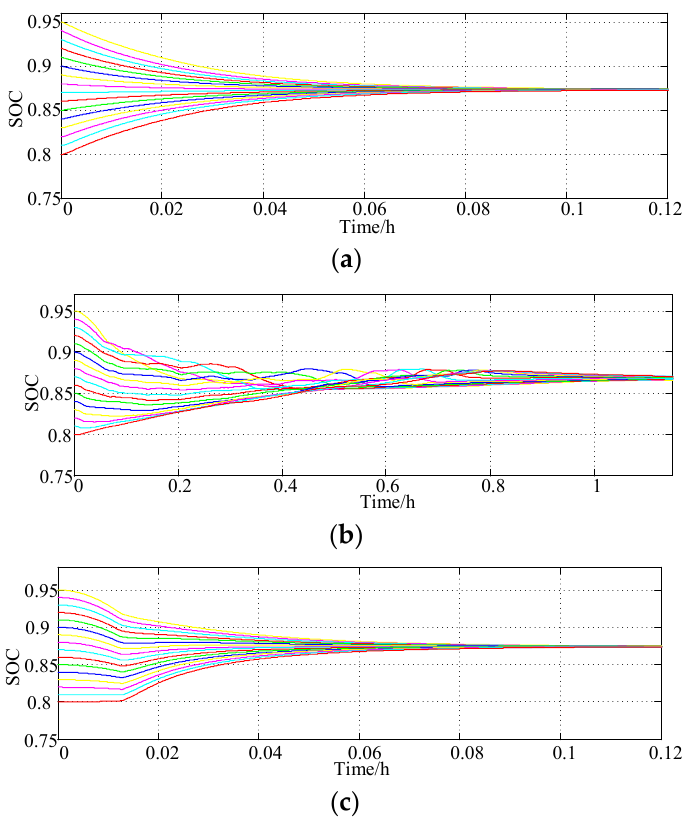
Figure 9. SOC of the cells. ( a ) The simplified equalisation scheme; ( b ) the series ‐ based equalisation